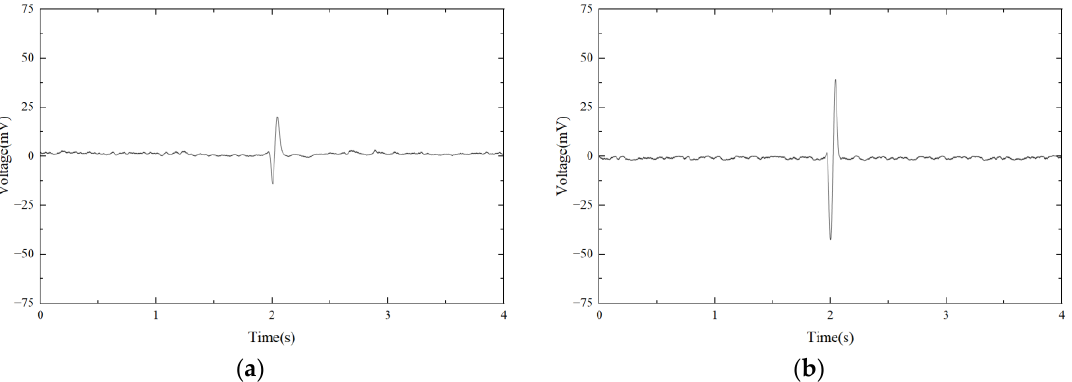
Figure 13. The output voltage waveform of copper particles at different excitation frequencies. ( a ) 80 kHz; ( b ) 160 kHz.